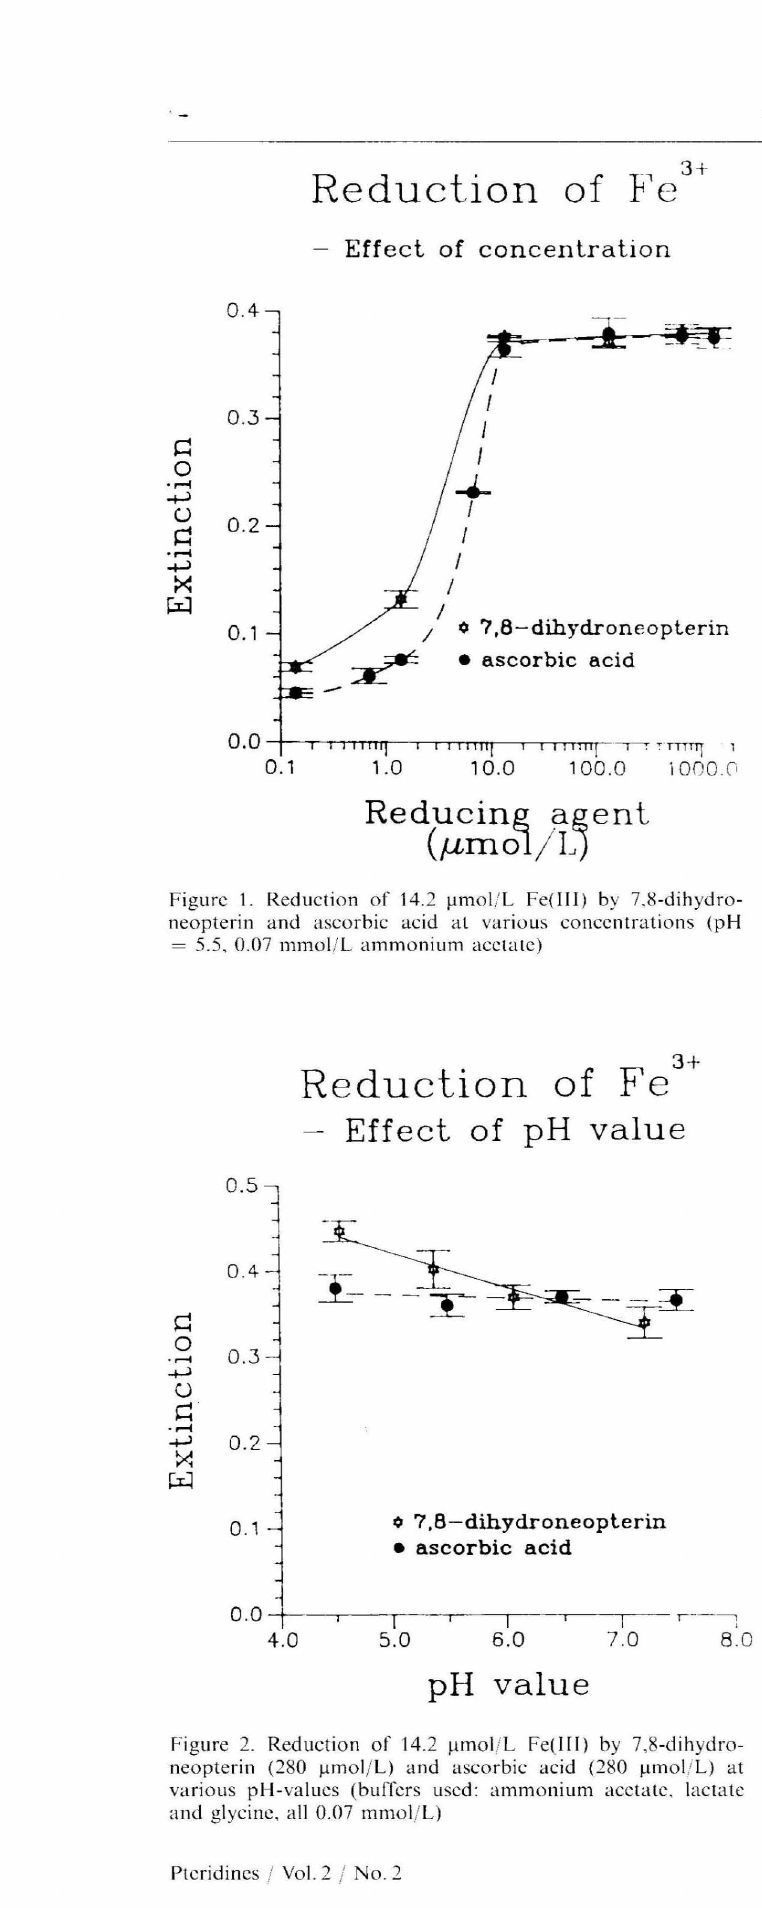
Figure 2. Reduction of 14.2 Ilmol/L Fe(lll) by 7.8-dihydro neopterin (280 Ilmol/L) and ascorbic acid (280 Ilmol/L) at various pH-valucs (buffcrs uscd: ammonium acctatc. lactatc and glycinc. all 0.07 mmol/L) Ptcridincs ! Vol. 2 !